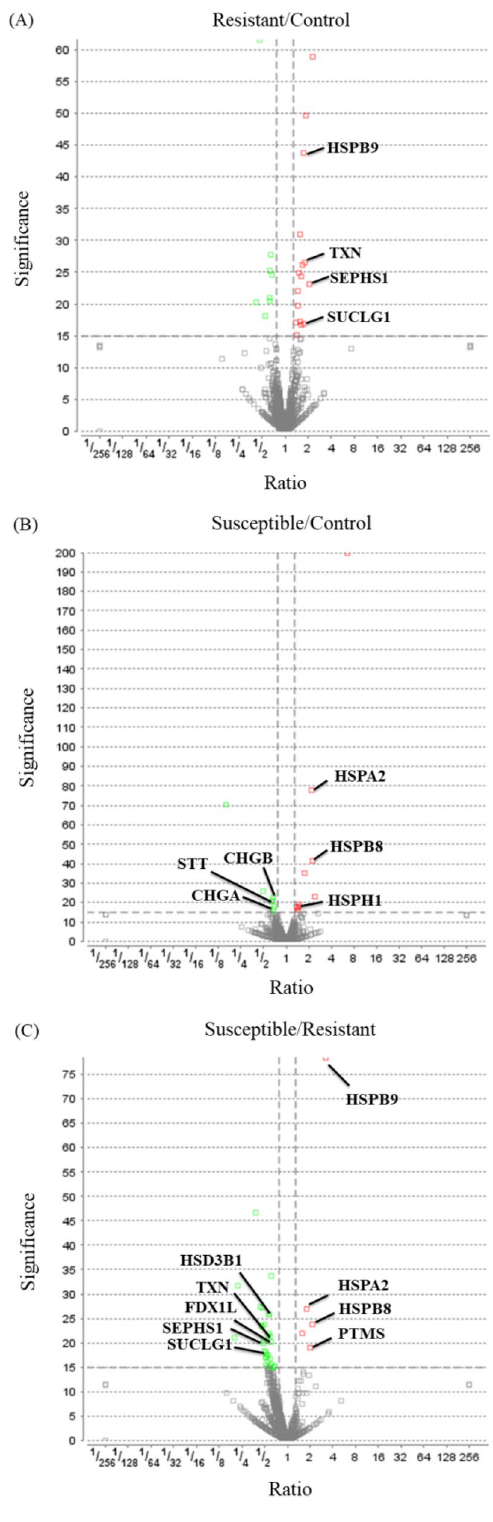
Figure 3. Volcano plots of three pairwise analyses for adrenal glands of male L2 strain TCCs by PEAKS Studio proteomics software (Version X, https:// www. bioin for. com/ peaks- studio/) comparing ( A ) Resistant/Control, ( B ) Susceptible/Control, ( C ) Susceptible/Resistant. Comparisons were presented as a statistical significance versus fold-change ratio of protein abundance. Red (upregulated) and green (downregulated) dots represent proteins with significance above 15 and with fold-changes larger than